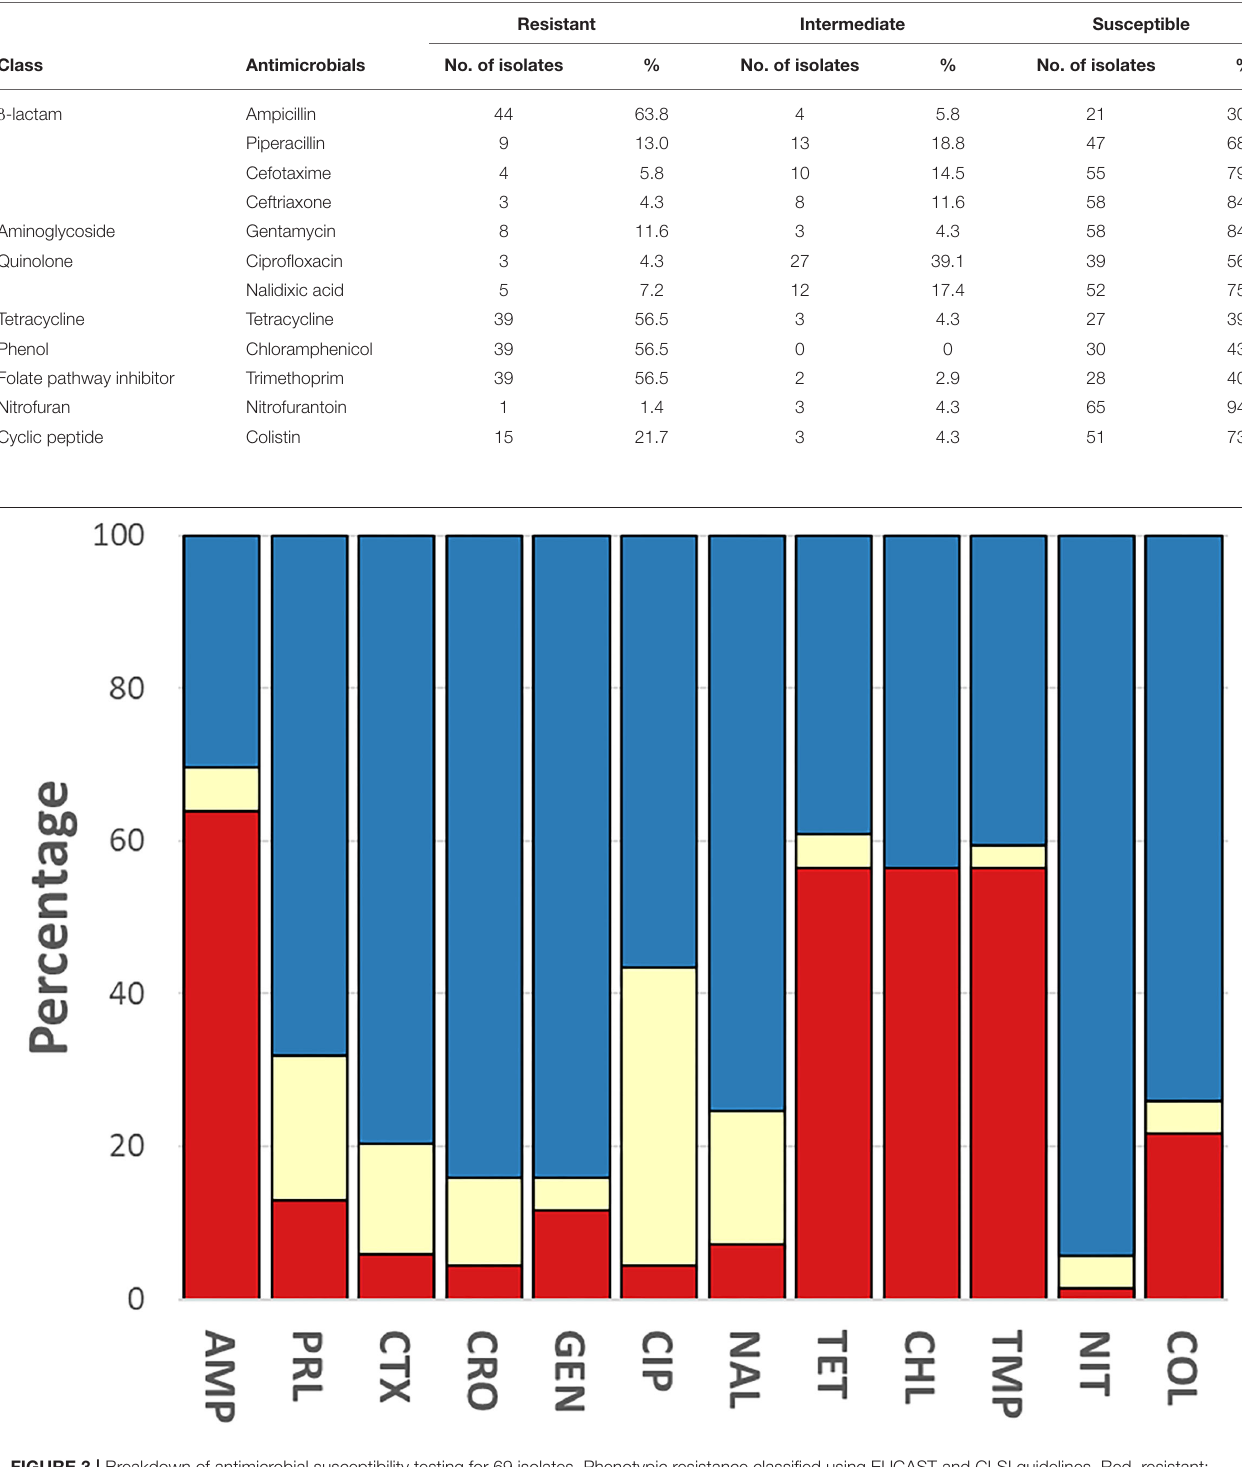
FIGURE 3 | Breakdown of antimicrobial susceptibility testing for 69 isolates. Phenotypic resistance classified using EUCAST and CLSI guidelines. Red, resistant; yellow, intermediate; blue, susceptible. Antibiotics were used as follows: ampicillin (AMP, 10 µ g), gentamycin (GEN, 10 µ g), trimethoprim (TMP, 5 µ g), tetracycline (TET, 30 µ g), nalidixic acid (NAL, 30 µ g), ciprofloxacin (CIP, 5 µ g), ceftriaxone (CRO, 30 µ g), cefotaxime (CTX, 30 µ g), piperacillin (PRL, 30 µ g), nitrofurantoin (NIT, 100 µ g), chloramphenicol (CHL, 30 µ g) (Oxoid, Basingstoke,